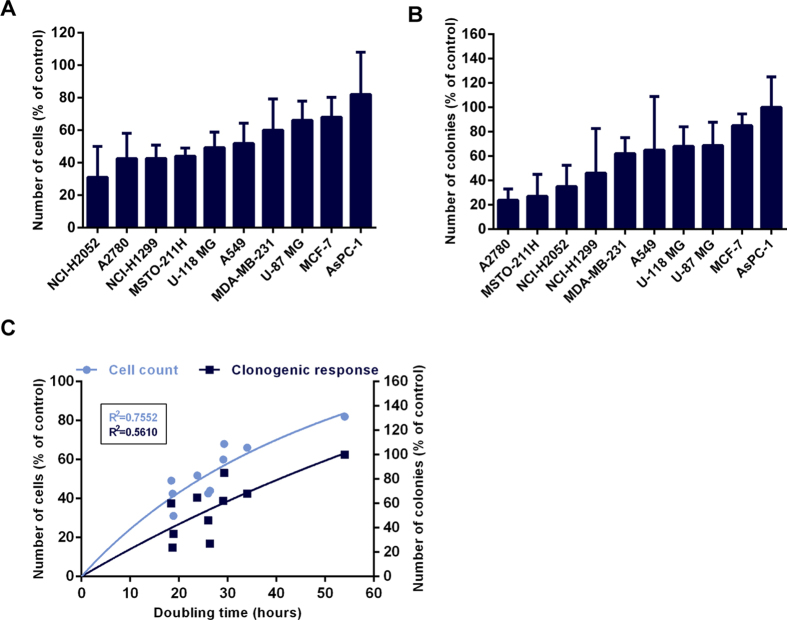
TTFields Treatment Efficacy Is Cell Doubling Time Dependent.Comparison of cell lines response to TTFields treatment. Cells were treated with TTFields for 72 hours at optimal frequency (Table 1). (A) Effect of TTFields treatment on cell count of various cancer cell lines. (B) Clonogenic survival of various cancer cell lines following TTFields treatment. (C) Correlation between cell doubling time and cell count (p = 0.008) and clonogenic response (p = 0.023) following TTFields treatment.